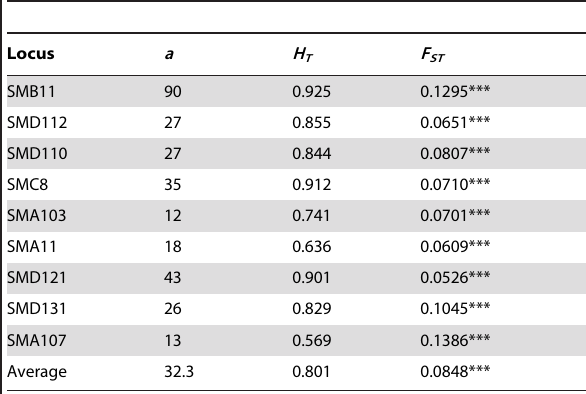
Table 2. Amount of genetic variability among corkwing wrasse samples at nine microsatellite